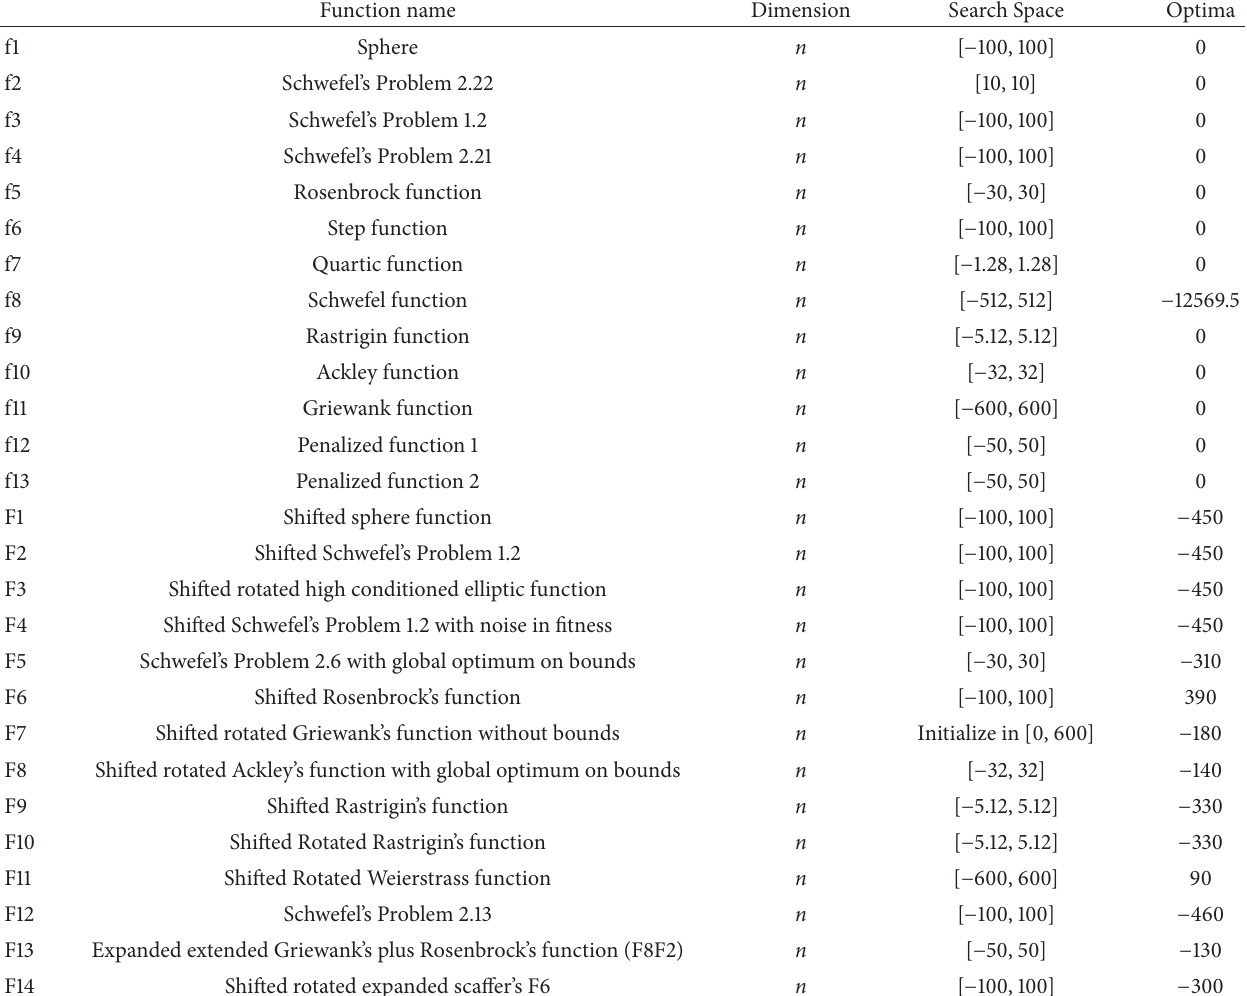
Table 1: Test unctions used in our experimental